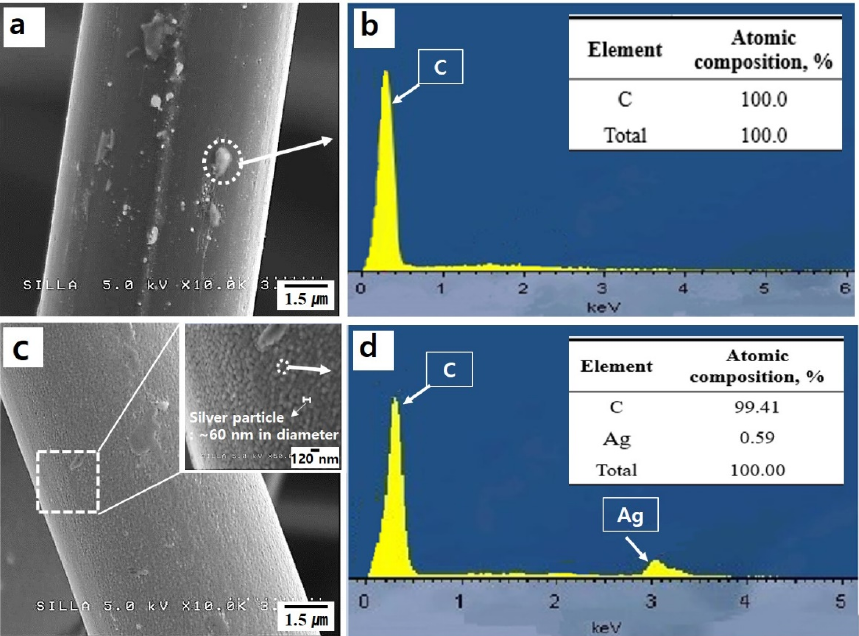
Figure 6. ( a ) A magnified FESEM image of an individual carbon fiber in a plasma-treated c-NFs sample and ( b ) the corresponding energy dispersive X-ray spectroscopy (EDS) spectrum obtained for the area inside the dotted-circle in Figure 6a. ( c ) A magnified FESEM image of an individual carbon fiber has inset showing silver particles in an Ag-coated c-NFs sample; and ( d ) the corresponding EDS spectrum for the area inside the dotted-circle in the inset of Figure 6c.